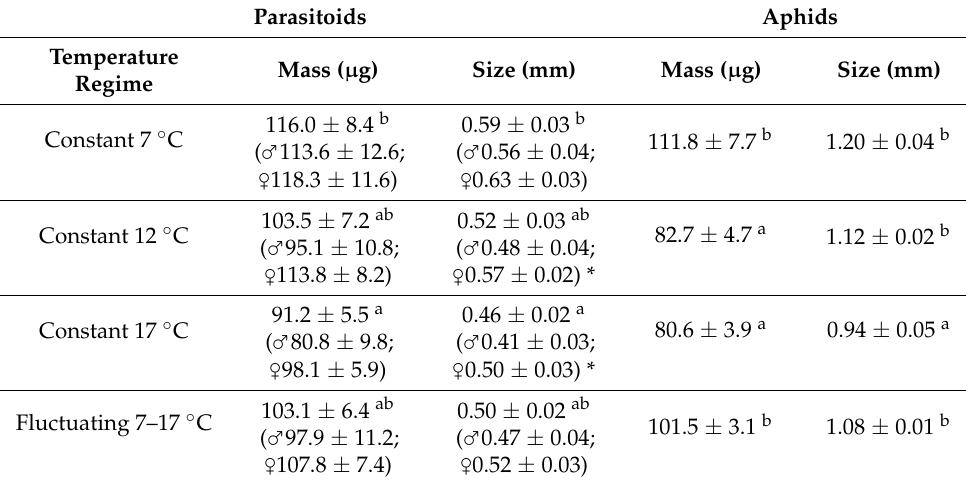
Table 2. Mass and tibia size (mean ± SE) of Aphidius matricariae parasitoids, detailed for both males ) and females ( ) , and of Dysaphis plantaginea aphids, exposed to three constant temperature ( ♀ ♂ regimes (7 ◦ C, 12 ◦ C, and 17 ◦ C) and one fluctuating temperature regime (7–17 ◦ C). N = 20, except for aphids at 7 ◦ C, where N = 13. Lowerscript letters indicate significant differences ( p < 0.05) among temperature regimes for each measured parameter. Stars (*) indicate significant differences ( p < 0.05) between males and females for a given temperature